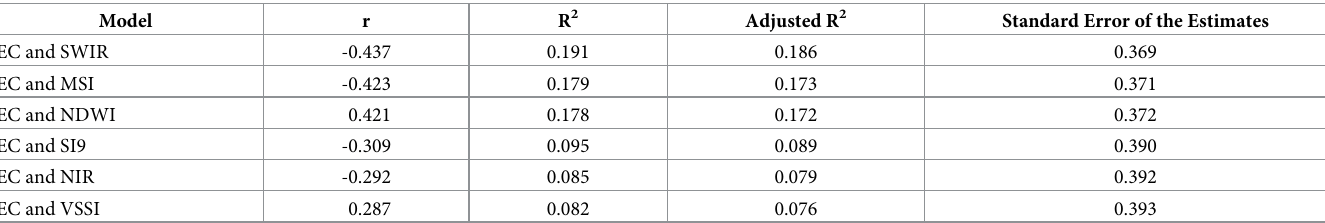
stability were moderate, and SAR, exchangeable Na, EC, ESP, sand, and organic matter con- tent were high. Pearson correlation between LogEC, Landsat TM satellite bands and indices are given in Table 5. The correlations between 23 different indices and band reflection values, and LogEC values were not statistically significant. The LogEC values had positive correlations with inde- pendent NDWI, VSSI, SI5, SI6 and NDSI variables (0.421, 0.287, 0.231, 0.228 and 0.108, respectively), while negative correlations were recorded with other variables (Table 5). The highest negative correlation with LogEC values was found for SWIR1 band (-0.437), followed by MSI (-0.423), SI9 (-0.309) and NIR (-0.292) independent variables. Linear regression test was applied to obtain a model between soil salinity and Landsat 5 TM satellite bands (SWIR1 and NIR) and indices calculated from the image (MSI, NDWI, SI9 and VSSI), which had the highest correlation coefficients. The results for linear regression test per- formed between indices and band variables, and logEC values are presented as model sum- mary (Table 6) and analysis of variance (Table 7). Information on the regression outputs and the variation explained by the models are given in Table 7. The regression sum of squares values of the strong models should be larger than the residual sum of squares values. The results of ANOVA indicated that the indices don’t explain the majority of total soil salinity variation in the study area. Salinity and vegetation indices could not provide a strong model to distinguish soil salinity in the region. Table 6. Summary of linear regressions for different models.